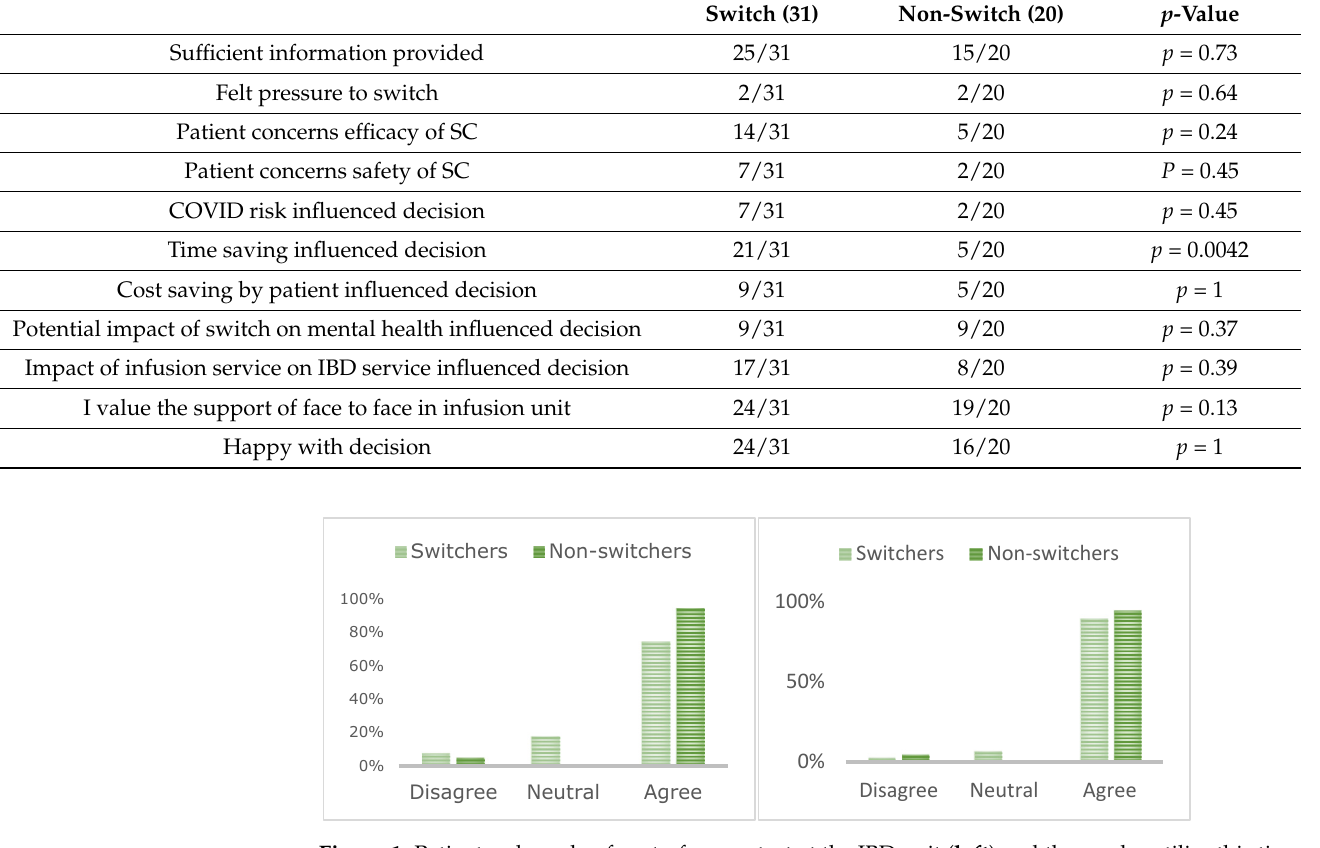
Table 2. Patient attitudes towards SC switch and satisfaction with the decision made.